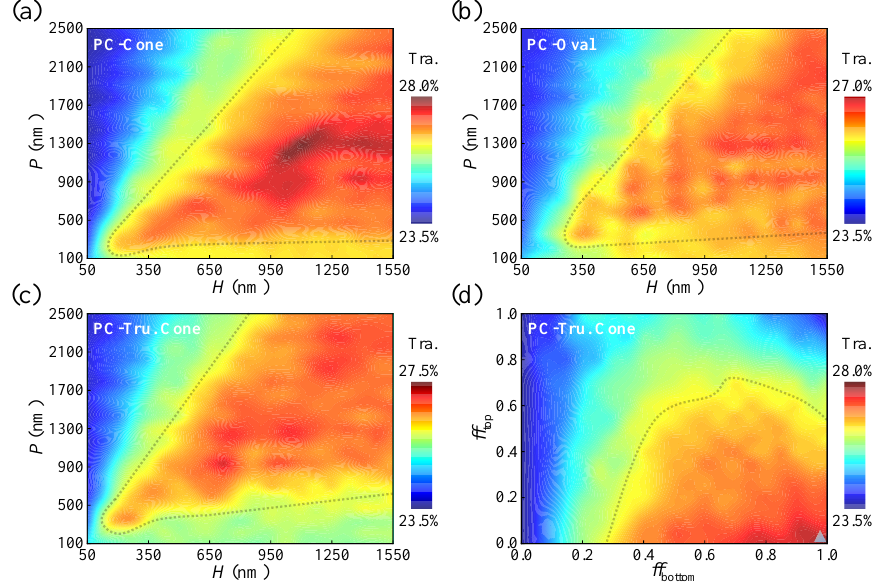
Figure 2. The average transmittances (Tra.) as functions of period P and height H for ( a ) nano-cone patterned PC (PC-Cone), ( b ) nano-oval patterned PC (PC-Oval) and ( c ) truncated nano-cone patterned PC (PC-Tru. Cone) cases. Here, ff was fixed at 1 for cases of PC-Cone and PC-Oval, and ff bottom ( ff top ) was fixed at 1 (0.3) for the case of PC-Tru. Cone. ( d ) Tra. of PC-Tru. Cone case under the various ff bottom and ff top , where the best point was marked by triangle.